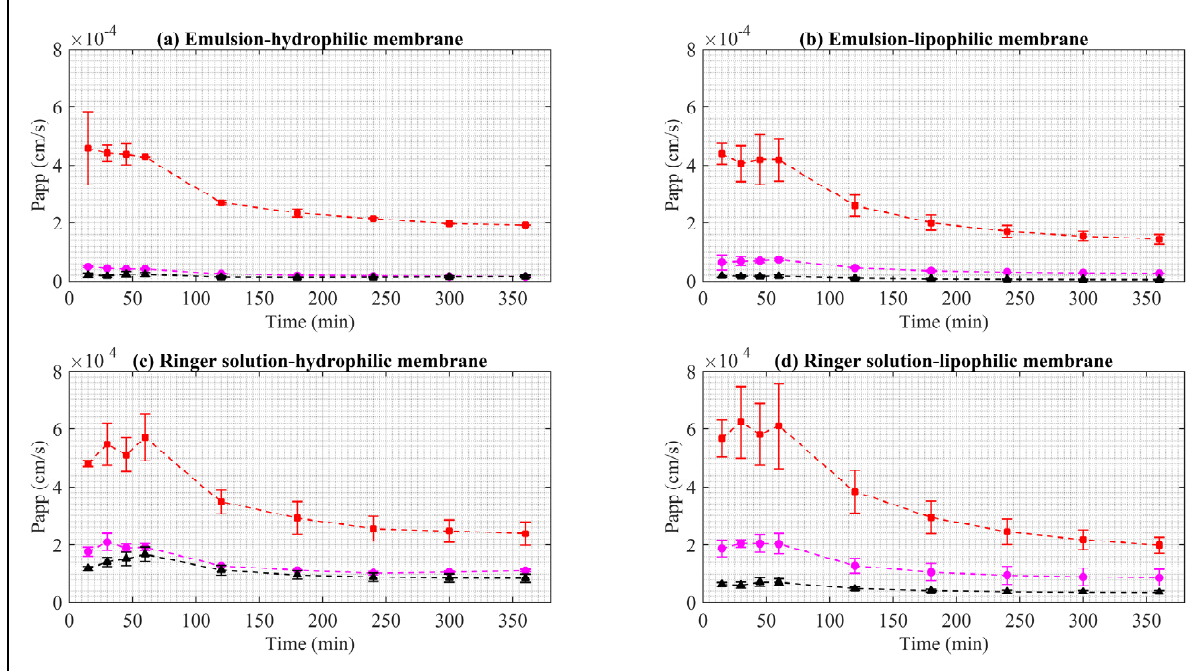
Figure 5. Apparent permeability of EB in synthetic membrane. Red squares represent EB–ALG microparticles, black triangles represent EB–SOL microparticles, and magenta circles represent free EB. ( a ) Represents emulsion as donor media with hydrophilic membrane (EM–H). ( b ) Represents emulsion as donor media with lipophilic membrane (EM–L). ( c ) Represents Ringer solution as donor media with hydrophilic membrane (RS–H). ( d ) Represents Ringer solution as donor media with lipophilic membrane (RS–L). Values represent the mean with standard deviation ( n = 3). Table 1. Apparent permeability results of synthetic